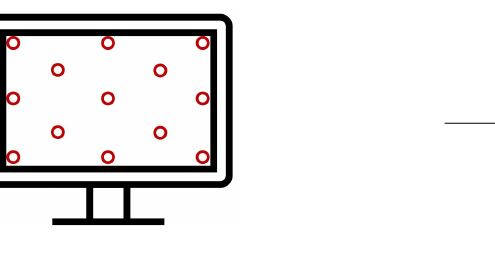
Figure 3. Left : The layout of the dot display for the calibration. Right : The timeline of an individual dot display and the subject image